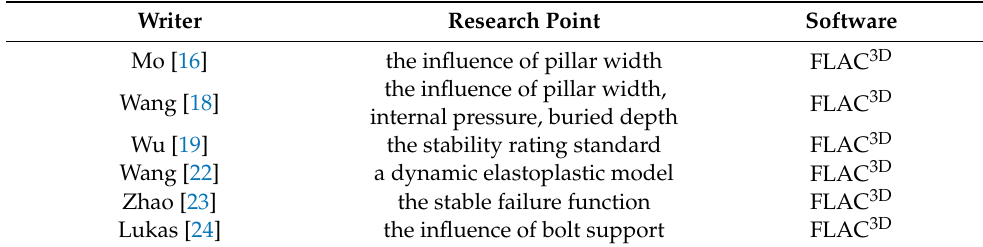
Table 3. Numerical simulation on FLAC 3D .